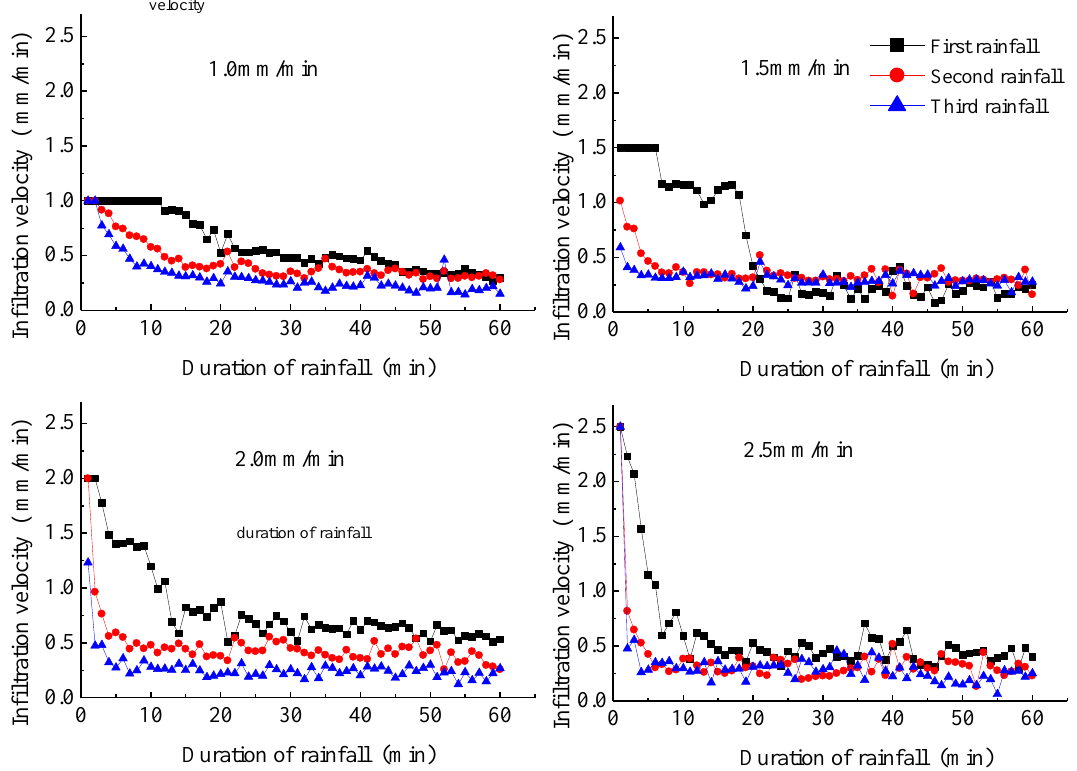
Figure 3. Infiltration velocity of the sand-covered slope.